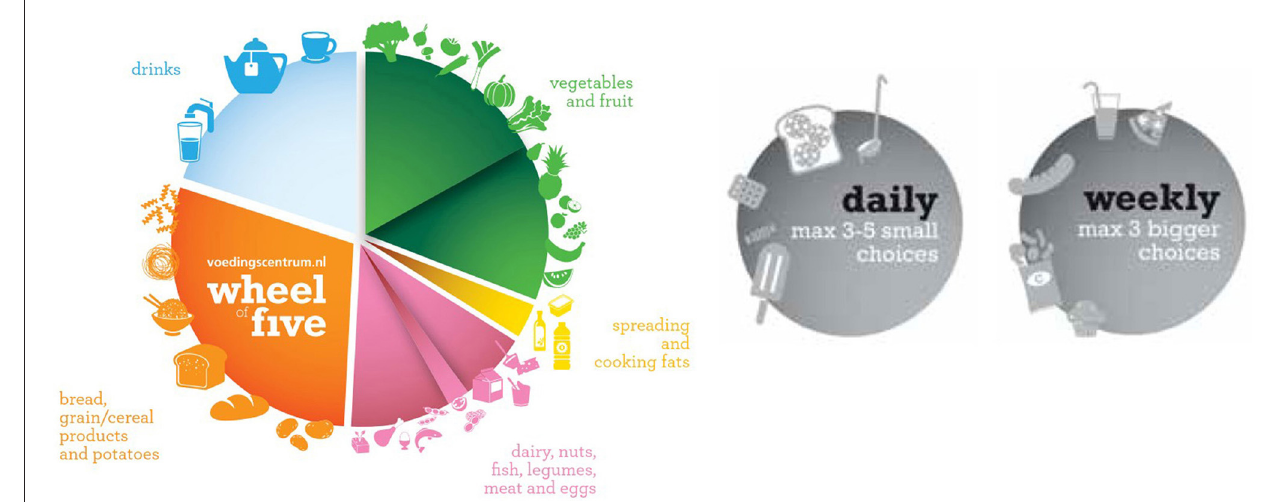
FIGURE 1 | Wheel of Five with the five food groups and a visualisation of Daily and Weekly choices (33).